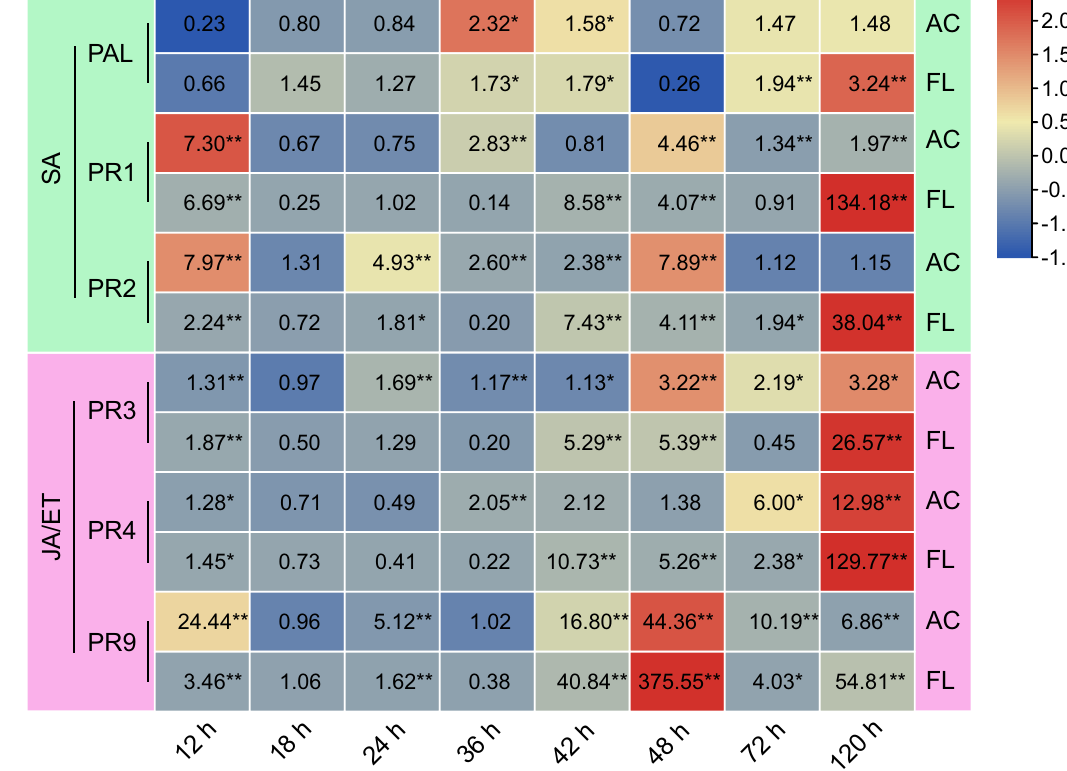
Fig. 5 Expression of defense-related genes in wheat leaves induced by XF. The first true leaf of wheat was sprayed with fermentation filtrate (FL) and actinomycete cell suspension (AC), and the second true leaves were collected at 12, 18, 24, 36, 42, 48, 72, and 120 hours post-inoculation (hpi) of XF. The horizontal axis in heat maps represents different time points, and each square shows the relative transcript levels of each gene in the AC or FL treatment. The heatmap was row-normalized using the scale method. The higher the gene expression, the hotter (redder) the color. An asterisk indicates significant differences based on the unpaired two-tailed Student’s t -test with the P values marked (* P < 0.05; ** P < 0.01) between treatments and the sterile distilled water (SDW) control, and only significantly up-regulated expressions are marked in the